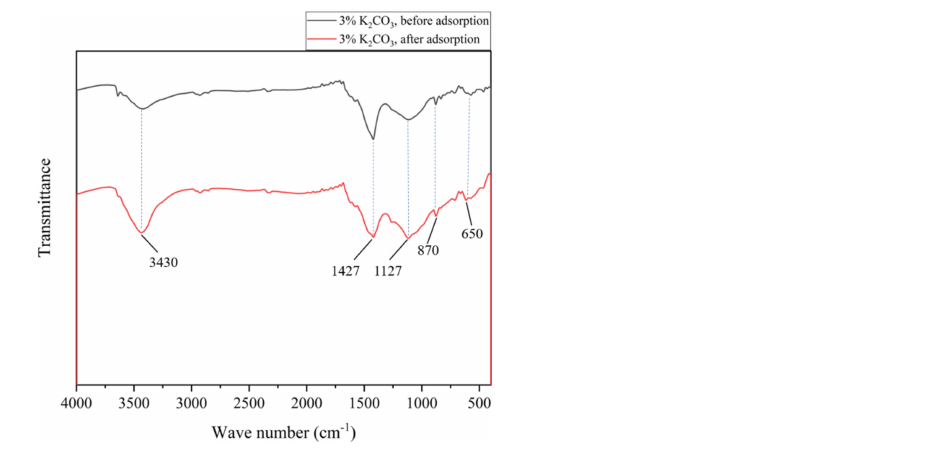
Figure 11. FTIR spectra of 3% K 2 CO 3 -modified activated coke before and after adsorption of SO 2 and NO.